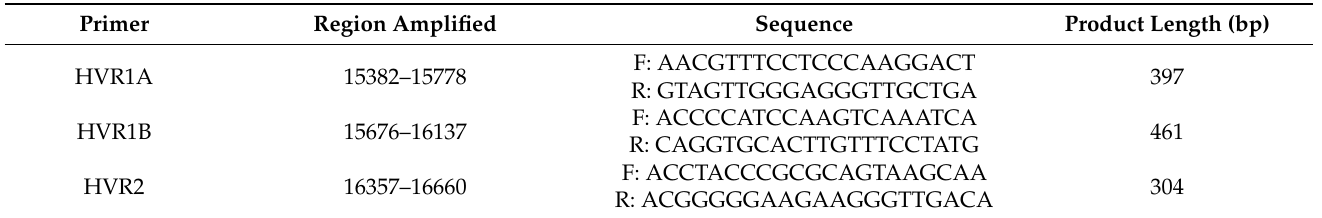
Table 1. Primer sequences used in the study: hypervariable region 1 (divided in two parts: A and B), and hypervariable region 2, with its product